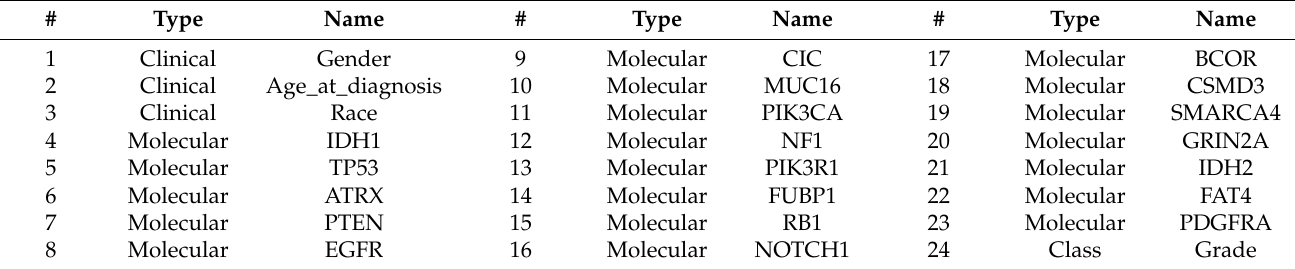
Table 2. Features and class information for the datasets used. TCGA has 23 class features (3 clinical, 20 molecular), whereas CGGA has 22 given it is comprised of a Chinese population with race not explicitly specified in the database.